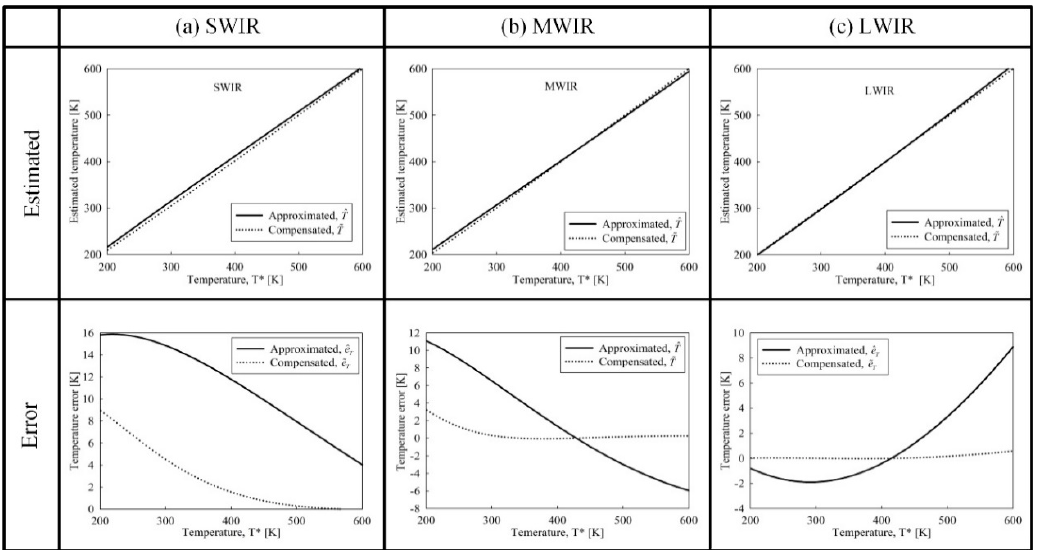
Figure 8. Approximately estimated and compensated temperature and temperature error for ( a ) short wavelength IR (SWIR), ( b ) MWIR-, and ( c ) LWIR-band of 200 K to 600 K.